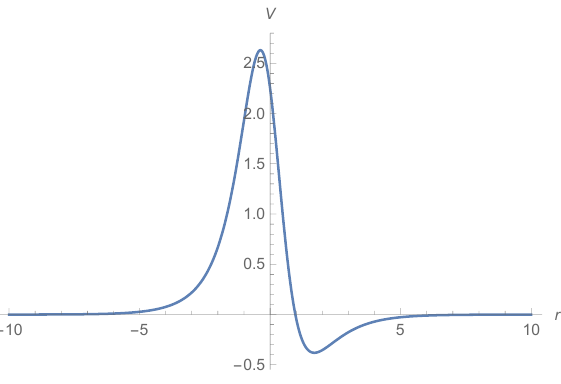
Figure 19 . The potential for q = 1 ; k = 1, it can develop a